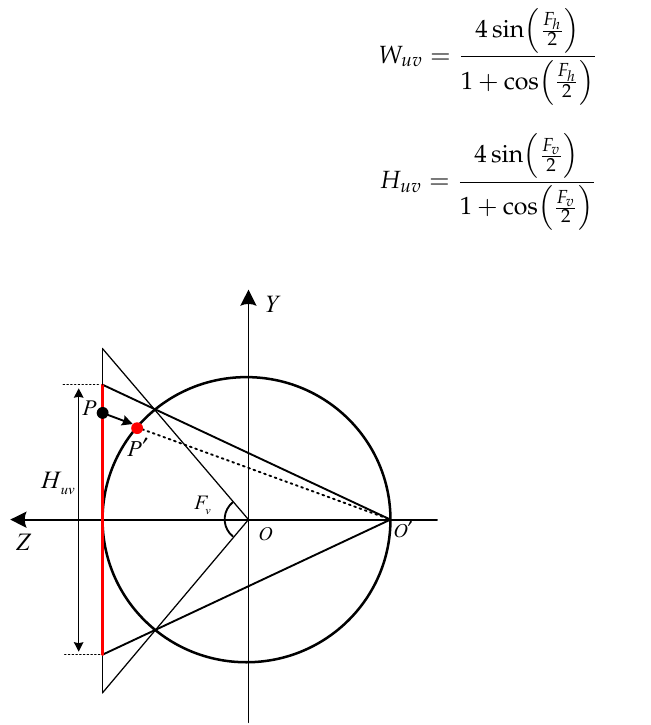
Figure 4. UV plane and sphere when the stereographic projection is used.